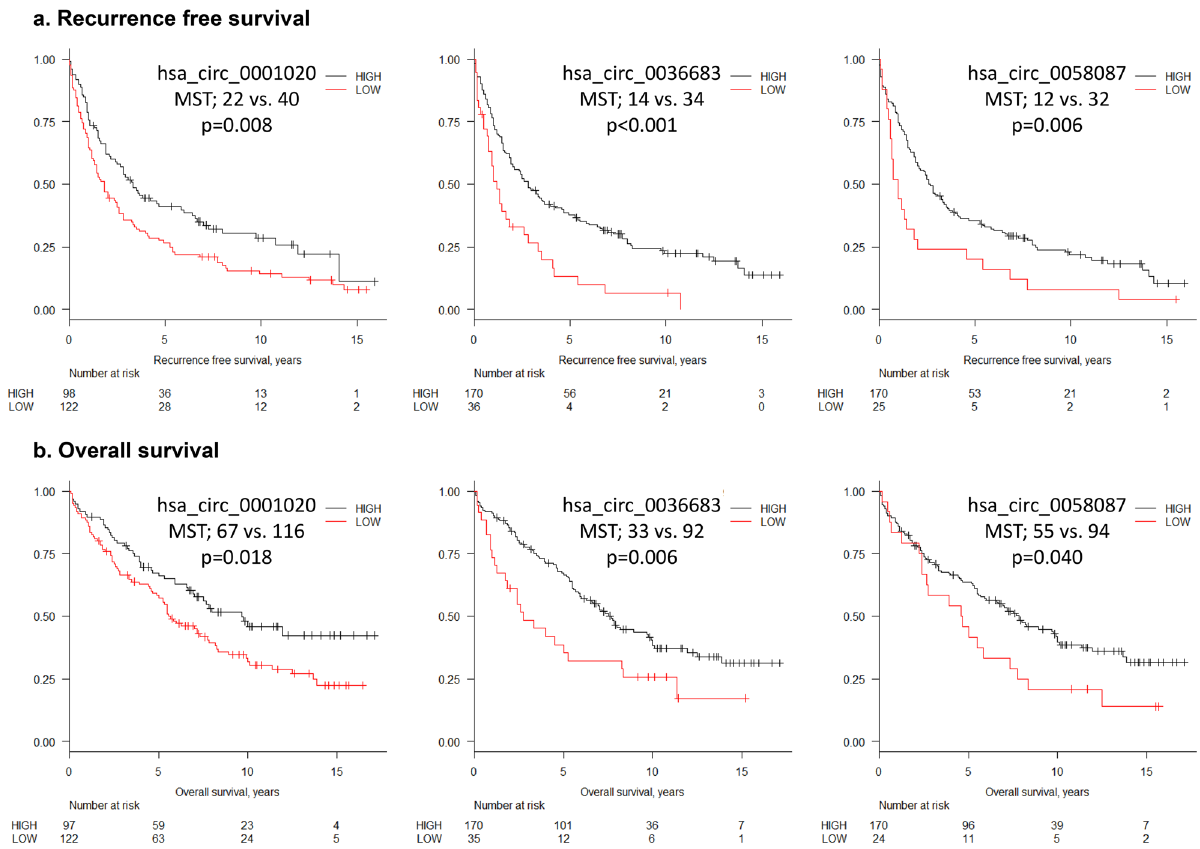
Figure 3. Recurrence free and overall survival based on the expression of hsa_circ_0001020, hsa_circ_0036683 and hsa_circ_0058087. ( a ) Recurrence free survival. ( b ) Overall survival. The figure is prepared using R software (version 3.5.3, https ://www.r-proje ct.org/) 43